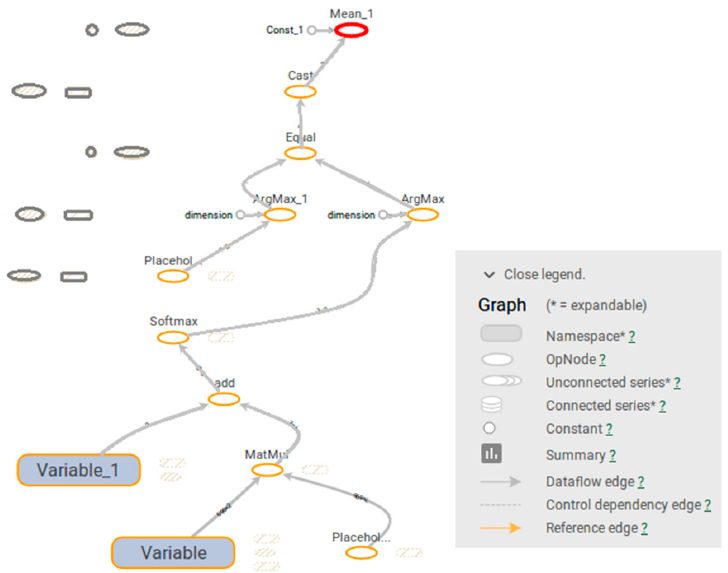
Figure 3. Comparison structure for the validation data application and Y value.